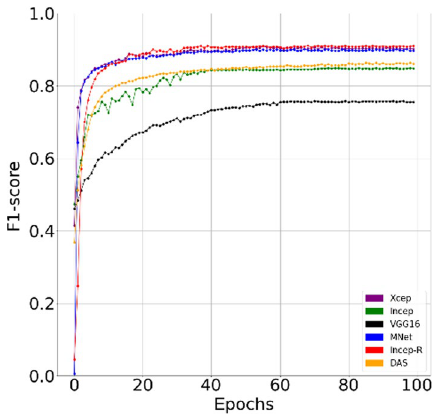
Fig. 8 Evolution of the F1-score during training of each model in the TenGeoP- SARwv dataset. Each curve represents the average of the F1-score along with the 50